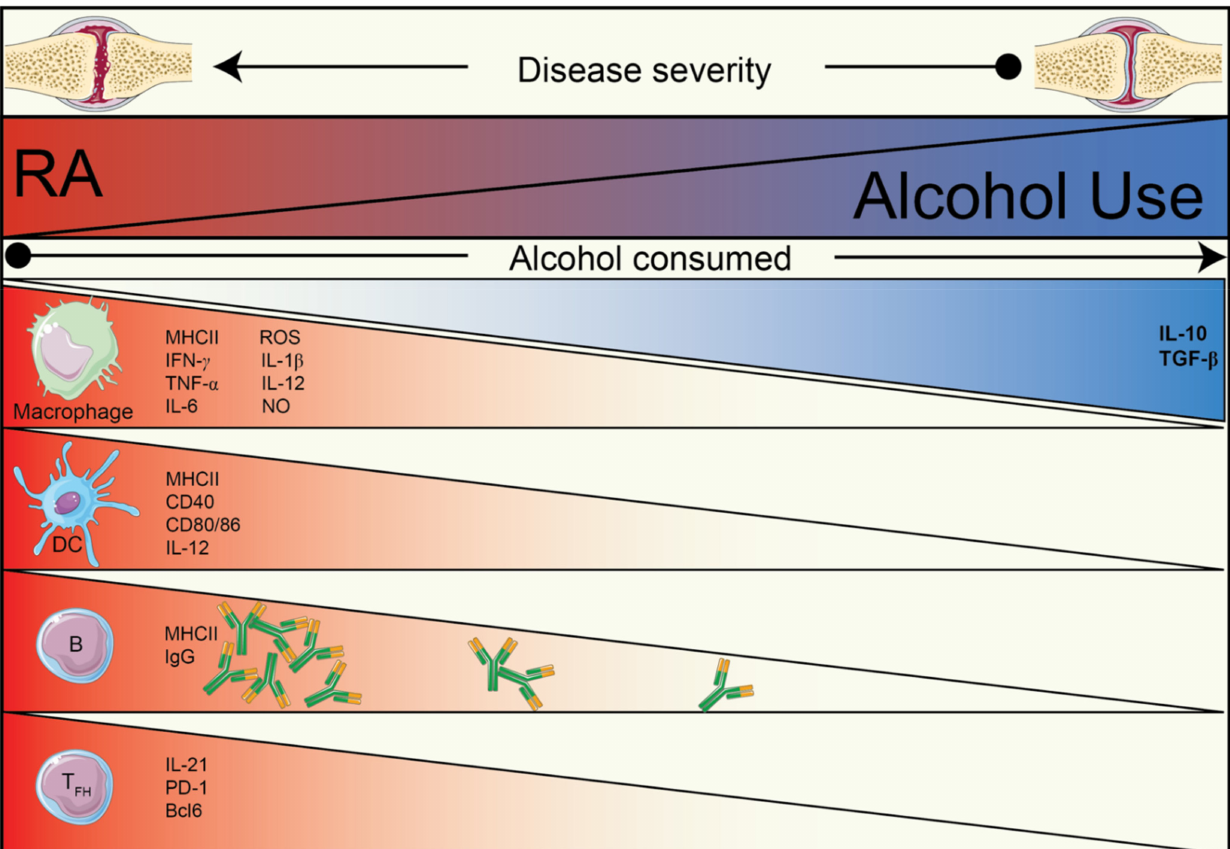
Figure 1. Summary of the inverse relationship of alcohol use and RA, grouped by known effects of alcohol and/or of its metabolites on different immune